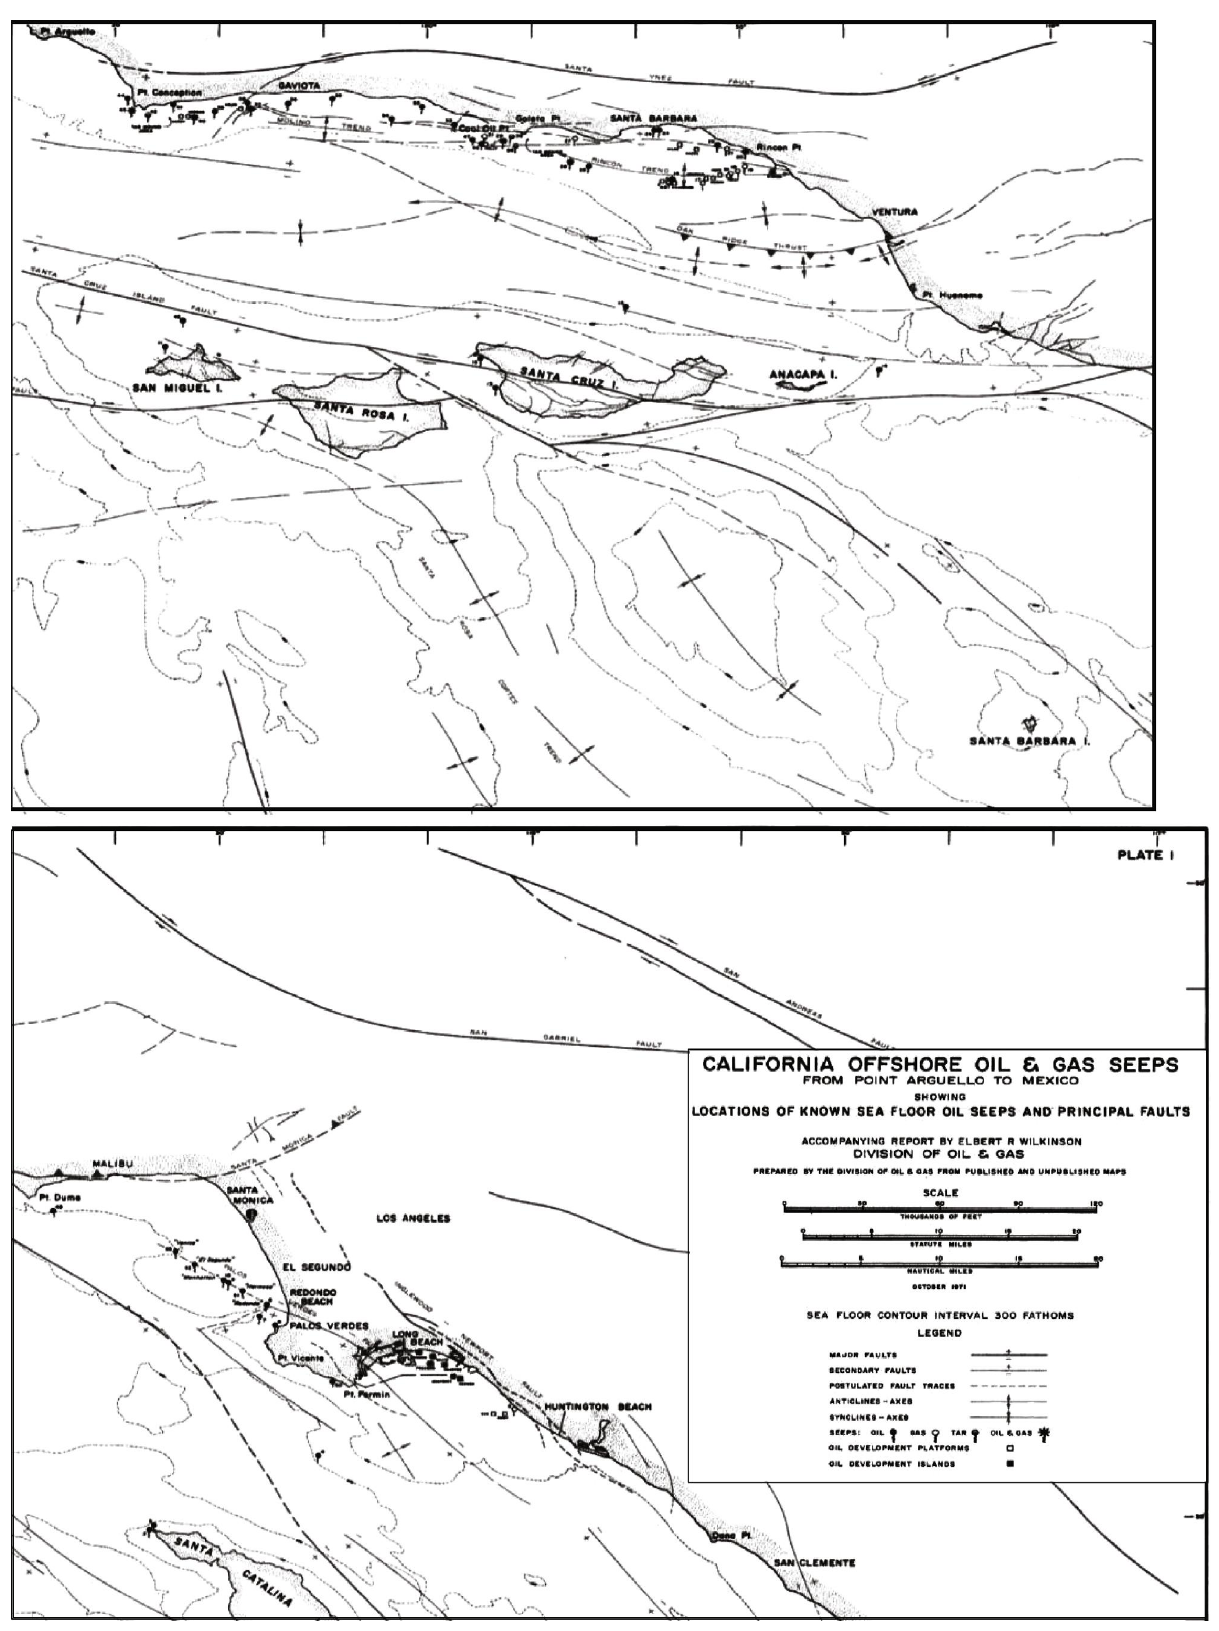
Figure 10: Southern California o ff shore seepage and major faults. Arrows show fault direction. From Wilkinson